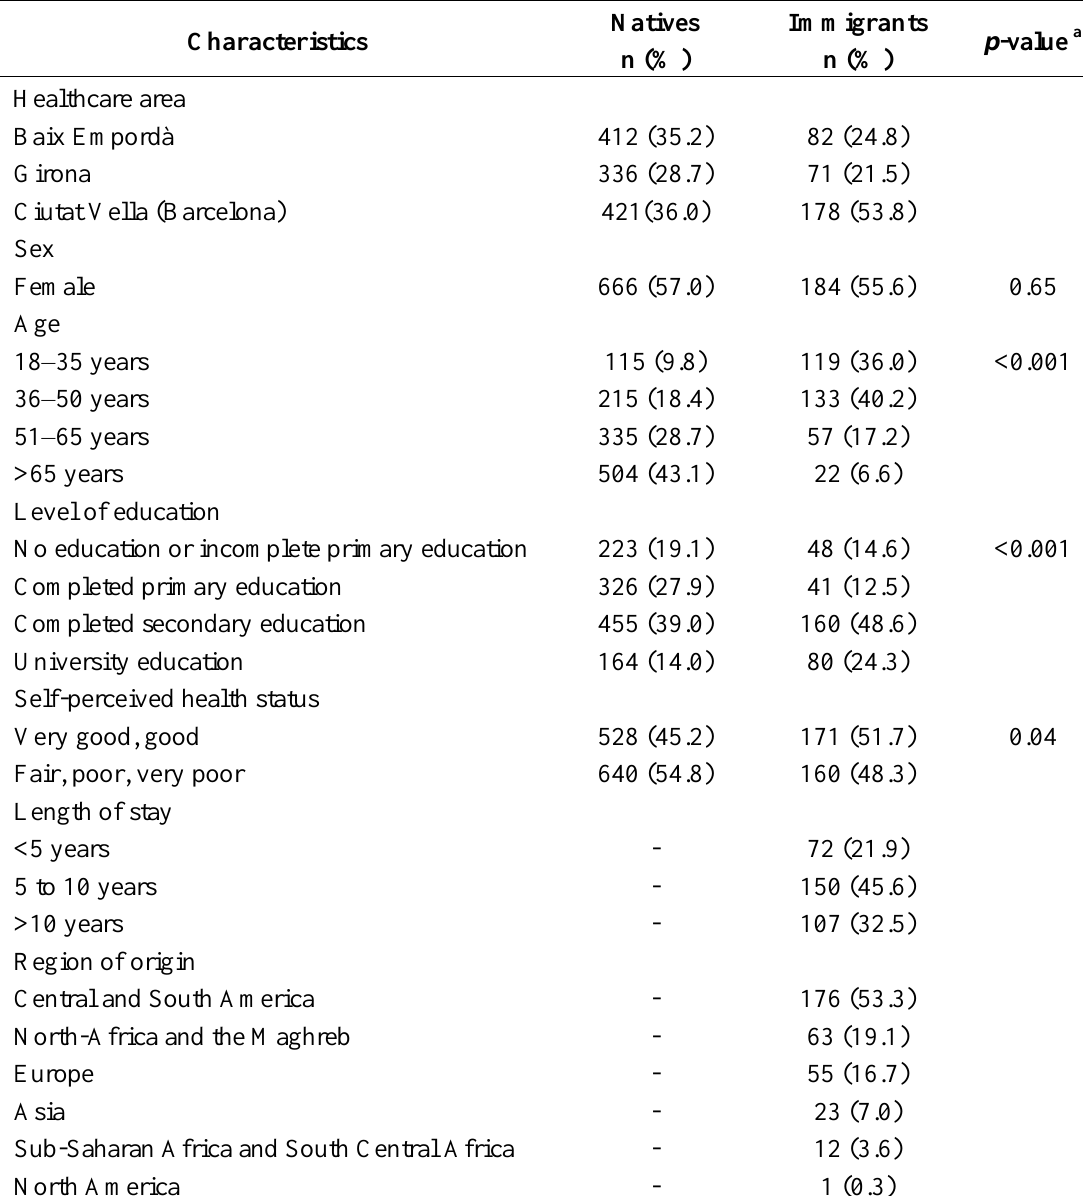
Table 1. Characteristics of the